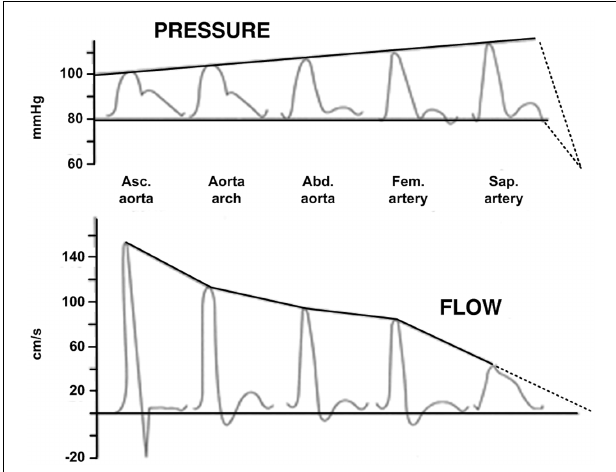
FIGURE 2 | Experimental arterial pressure and flow waveforms with increasing distance from the heart. Reproduced from Nichols and O’Rourke